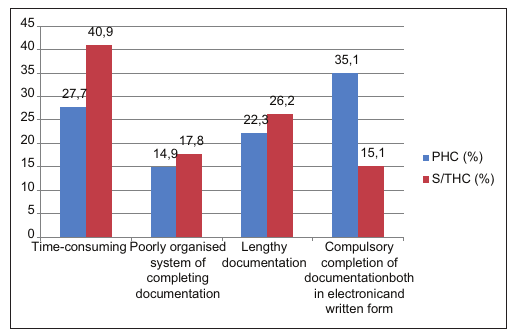
GRAPH 3. Disadvantages of submitted nursing